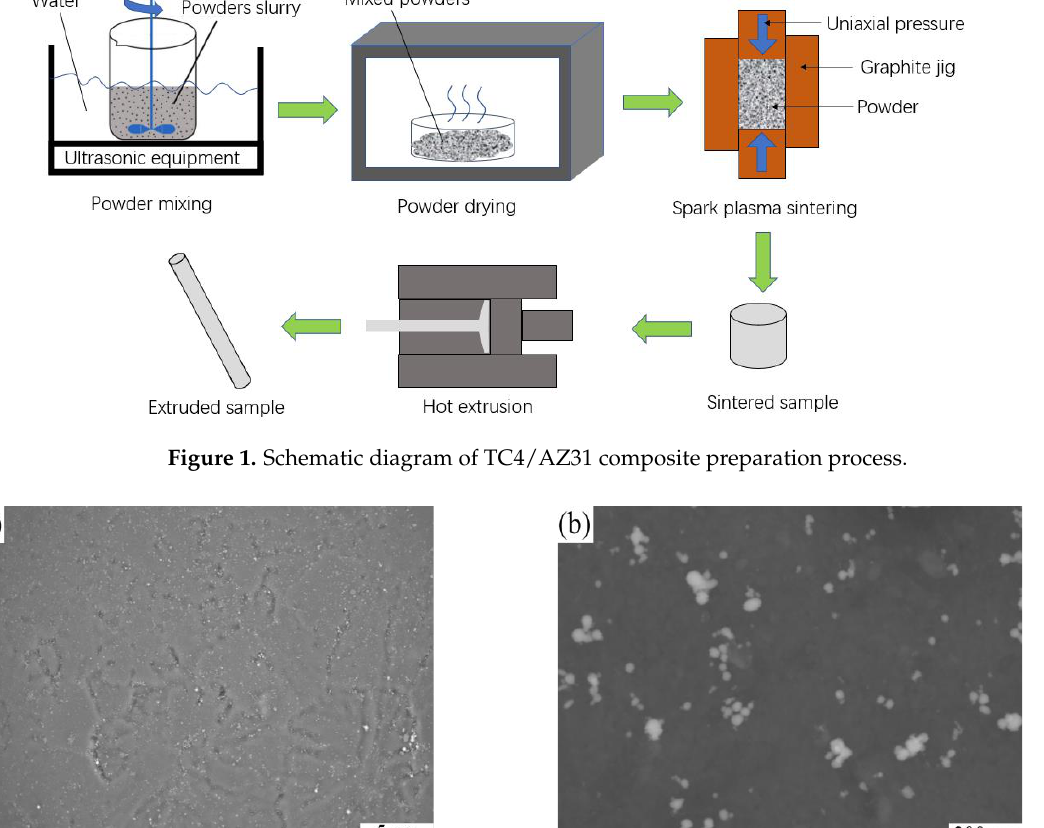
Figure 2. Low-magnification SEM ( a ) and high-magnification SEM ( b ) of 1 wt.%TC4 nanoparticles’ dispersion on the surface of magnesium powder particles.